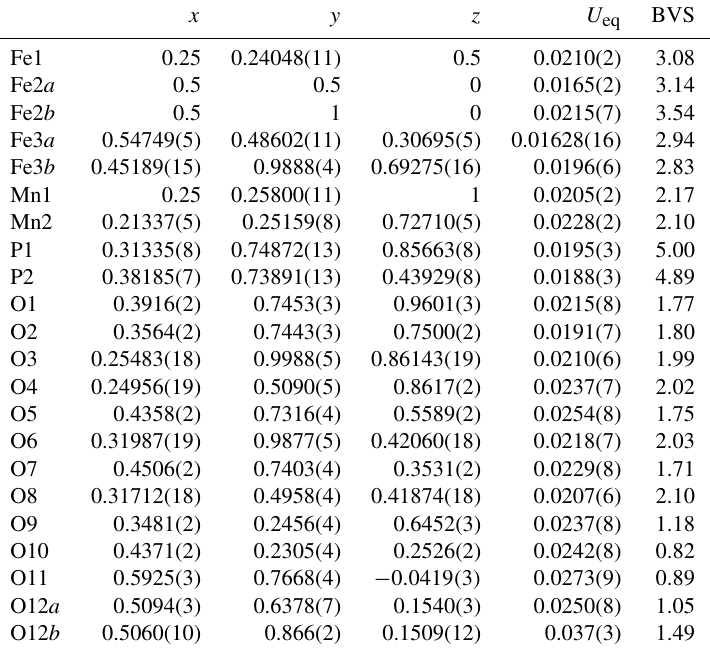
Table 3. Atom coordinates, equivalent isotropic displacement parameters (Å 2 ) and bond-valence sums (BVSs) for